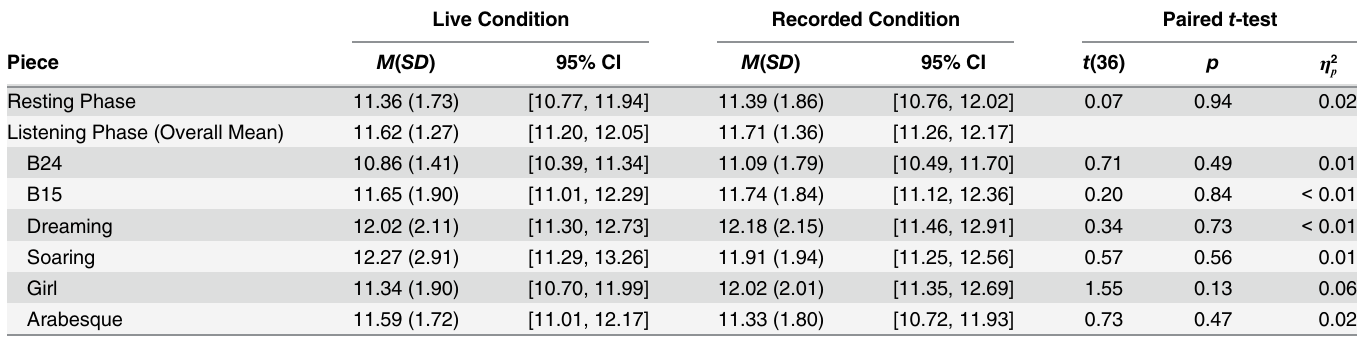
Table 1. The mean values, the standard deviations, and 95% confidence intervals of audience ’ s acceleration (mG) for each piece in each condition ( N = 37). Results of paired t -tests between the listening conditions were shown in the right columns. Live Condition Recorded Condition Paired t